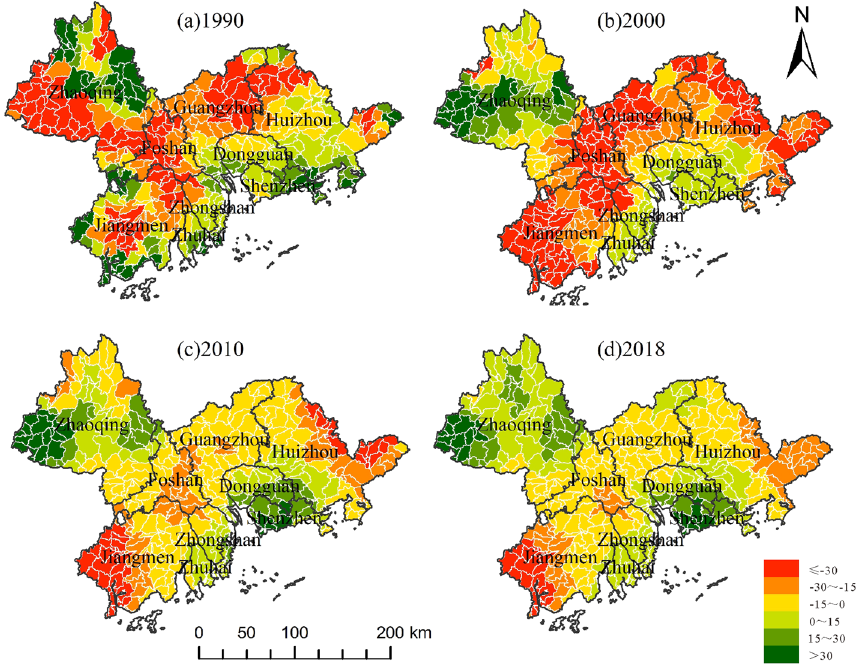
Figure 7. Spatial pattern of correlation coefficient between NTL and habitat quality.